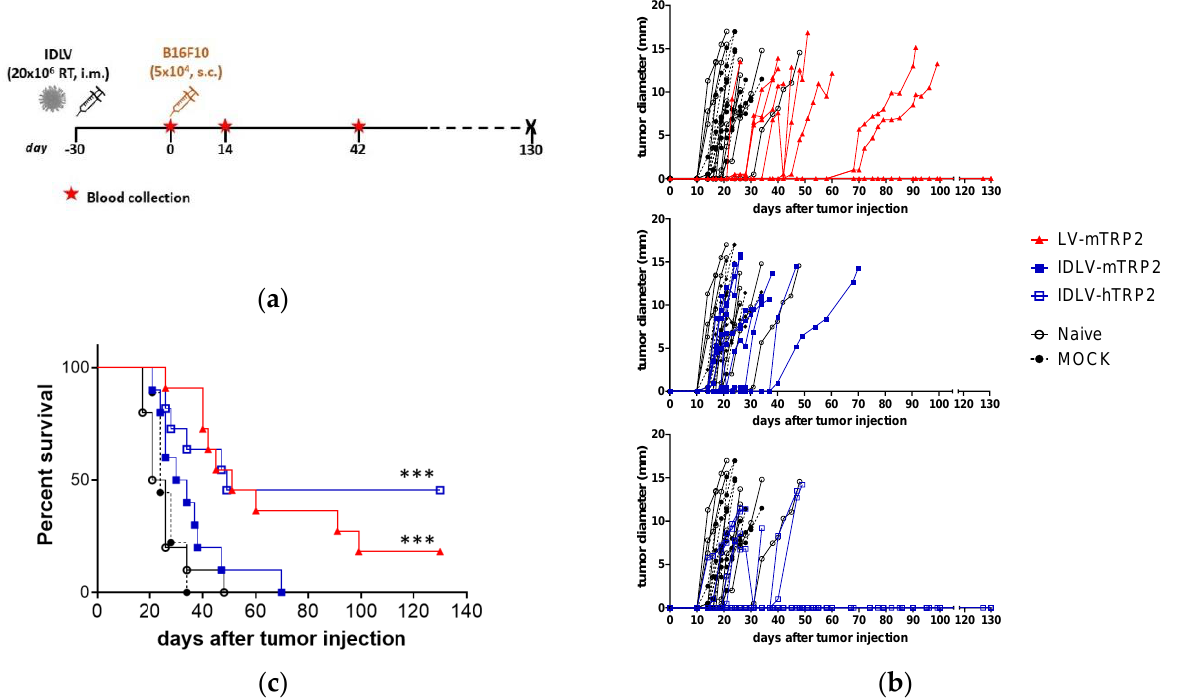
Figure 7. Antitumor efficacy of lentiviral vectors expressing either murine or human TRP2. ( a ) Scheme of the experiment. C57BL/6 mice ( n = 9–11) were immunized with vectors expressing TRP2, OVA (Mock) or left untreated. After 30 days all mice were s.c. injected with 5 × 10 4 B16F10 cells/mouse. ( b ) Tumor growth was monitored over time. All groups developed a tumor mass measured until the end of the experiment. Mock and Naïve groups were sacrificed within 32 days from tumor injection. ( c ) Survival was monitored over time and Kaplan–Meier survival curve is shown. Mice with tumor diam- eter >15 mm or a serious ulceration were sacrificed. (Log-rank Mantel-Cox test, *** p < 0.0001).